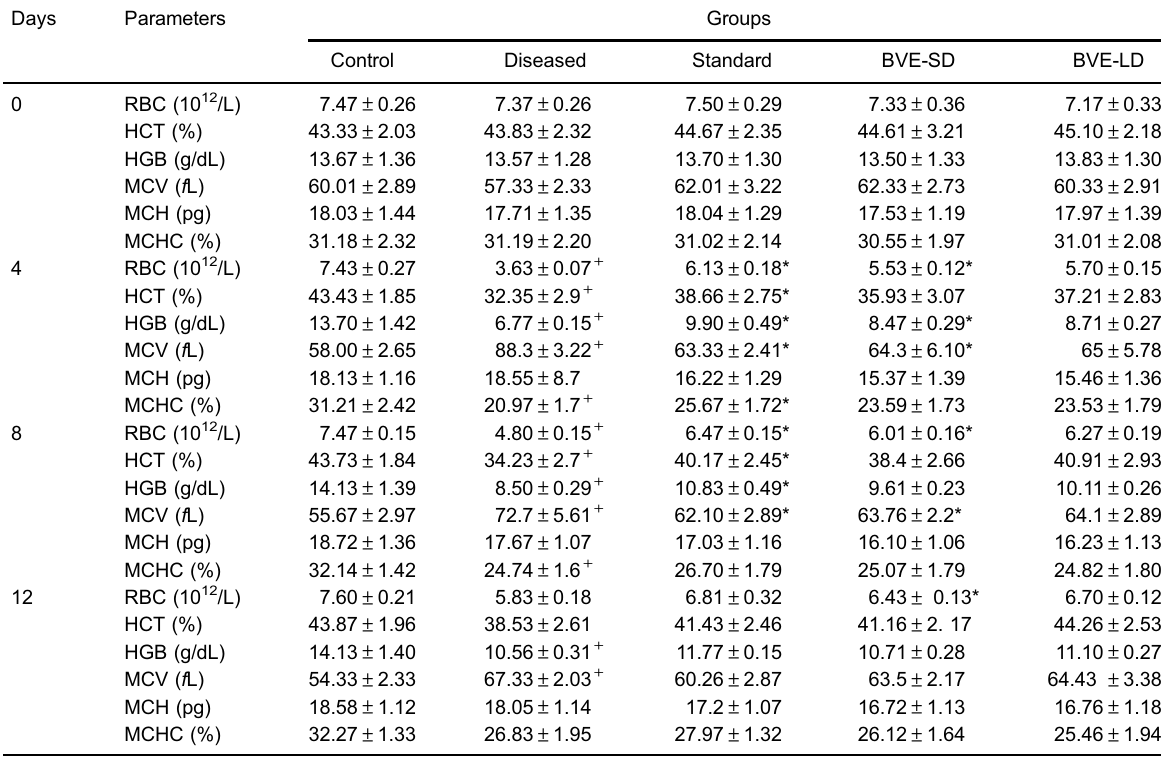
Table 1. Erythrogram after intraperitoneal injections of phenylhydrazine (20 mg/kg bw, for two consecutive days) and oral administration of Beta vulgaris leaf and stalk extract (BVE-LD, BVE-SD, 100 and 200 mg/kg bw, for 12 consecutive days) on erythrocytic parameters of rats compared to those after the standard ferrous ascorbate + folate (13.5 + 0.135 mg/kg bw, for 12 consecutive days) and normal control